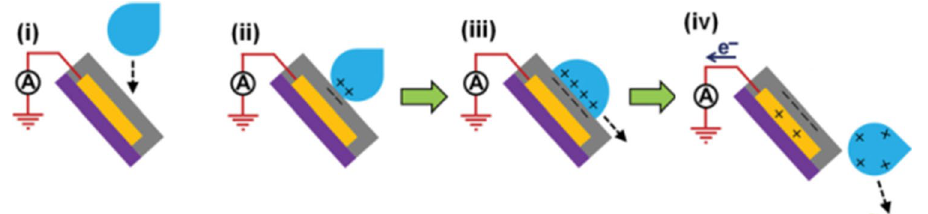
Figure 9. Working mechanism of the solid–liquid TENG.